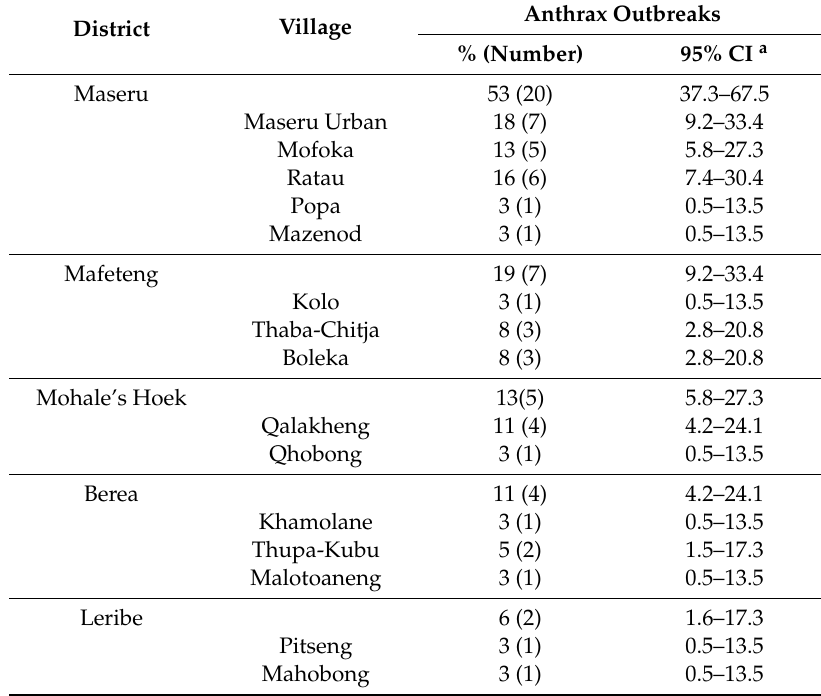
Table 1. Proportions of anthrax outbreaks in Lesotho by district and village between 2005 and 2016 (N =